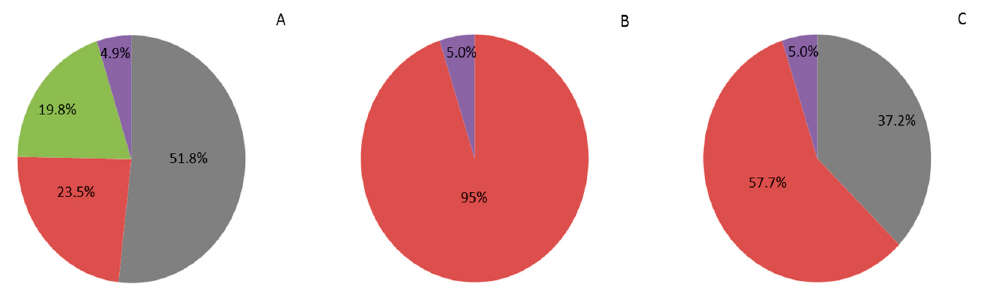
rejected (petite size).